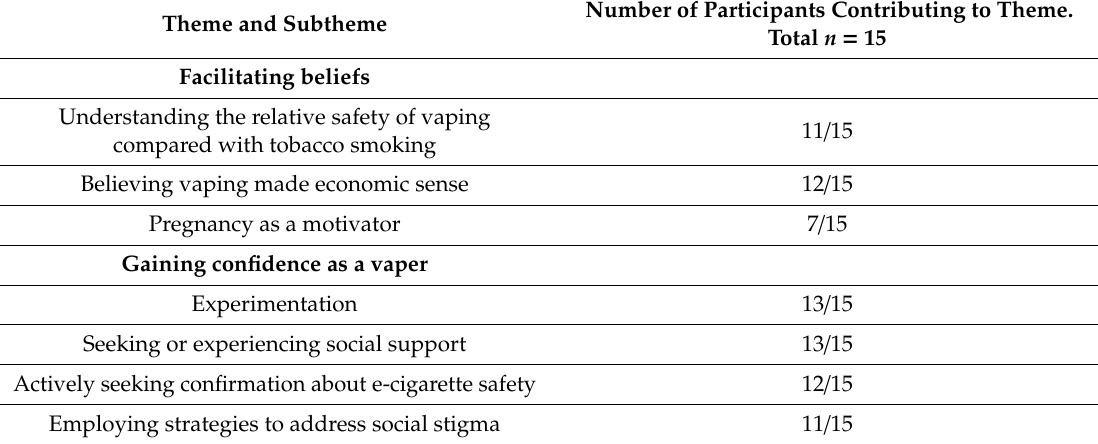
Table 1. Summary of participants contribution to each